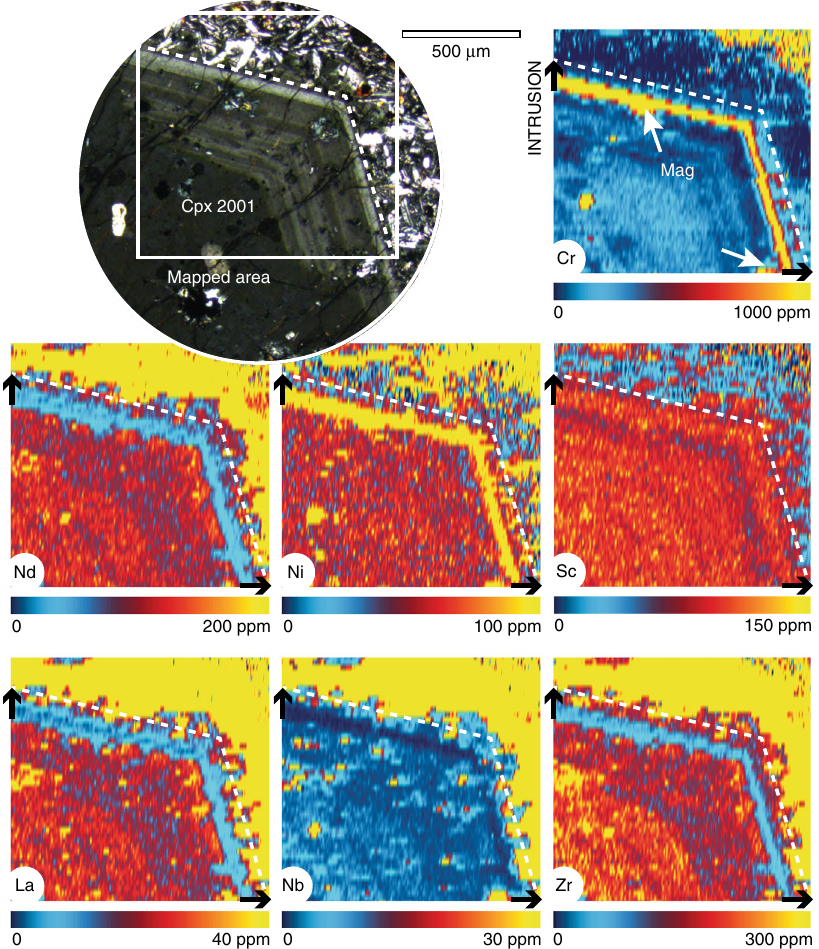
Fig. 1 Trace element maps of a clinopyroxene antecryst from the 2001 eccentric eruption at Mt. Etna showing primitive magma intrusion prior to eruption. Recharge with primitive magma is recorded as a rim rich in Cr and other compatible metals (Ni, Sc), and depleted in incompatible elements (rare earth La, Nd; high- fi eld strength Zr, Nb). Titanomagnetite (Mag) inclusions are typically associated with Cr-rich clinopyroxene (see white arrows). The maps are quantitative for clinopyroxene and semi-quantitative for other phases (e.g. in the groundmass). Higher concentration levels are indicated by warmer colours on linear scales within the indicated limits. The photomicrograph (transmitted light, crossed polars) provides context, the dashed white line marks the outline of the crystal, and the black arrows mark clinopyroxene growth upon magma intrusion, generating a Cr-rich rim and a Cr-poor outermost